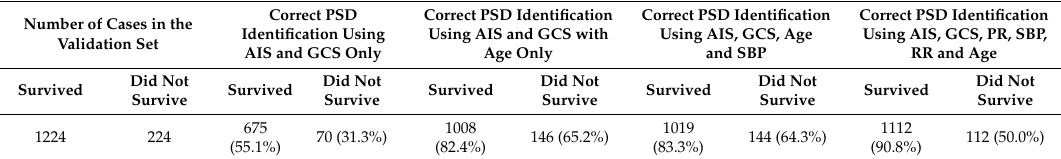
Table 11. Illustration of the effect of age, pulse rate (PR), systolic blood pressure (SBP) and respiratory rate (RR) on PSD performance in identifying surviving and not-surviving cases included in the validation